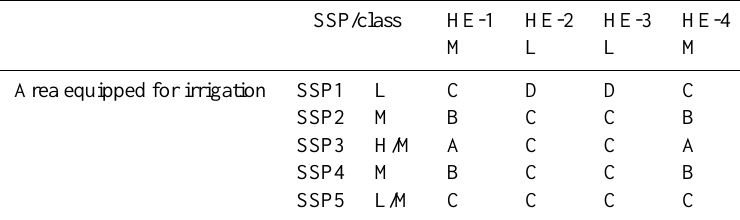
Table A20. Water dimension – rating the growth of areas equipped for